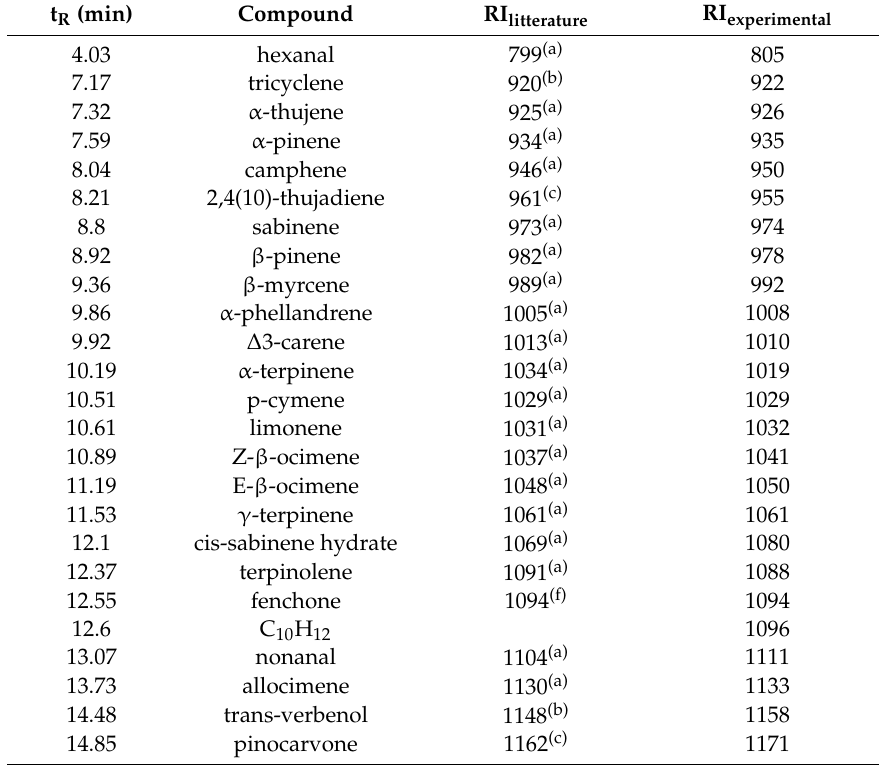
Table 3. Volatile organic compounds identified in the pistachio material headspace